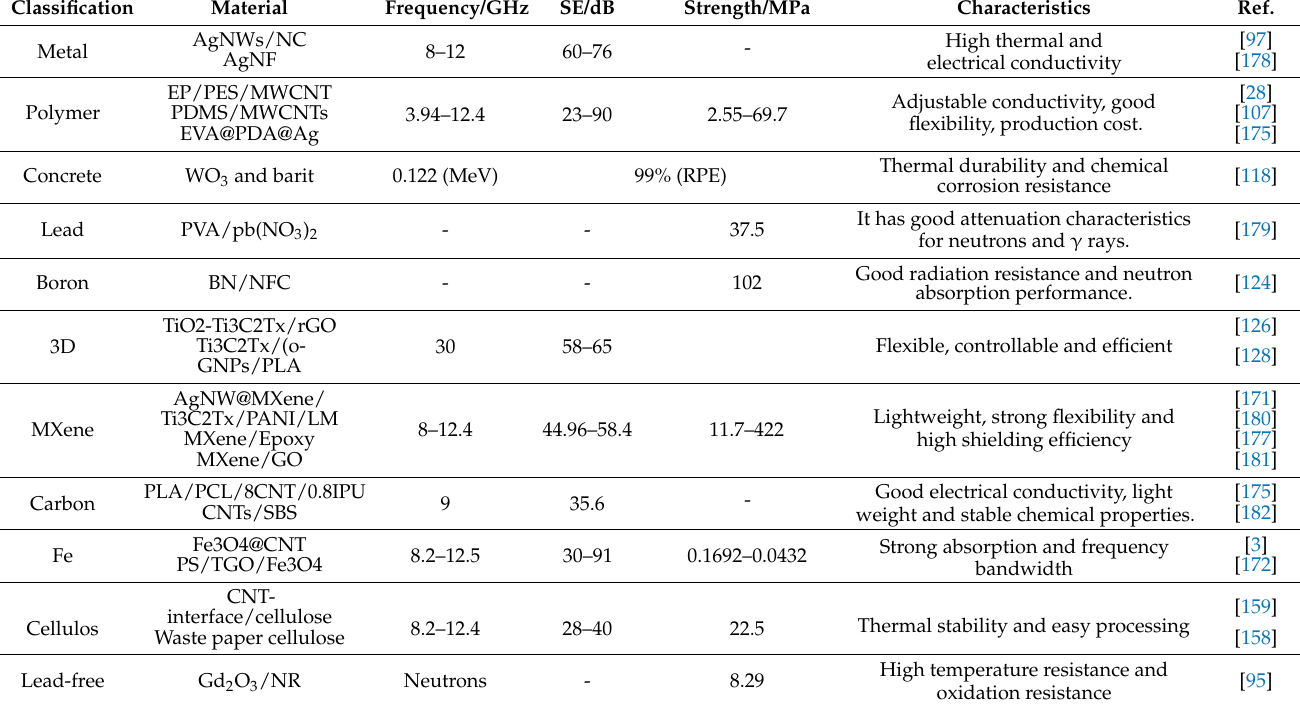
Table 1. Summary of the properties of some membrane shielding